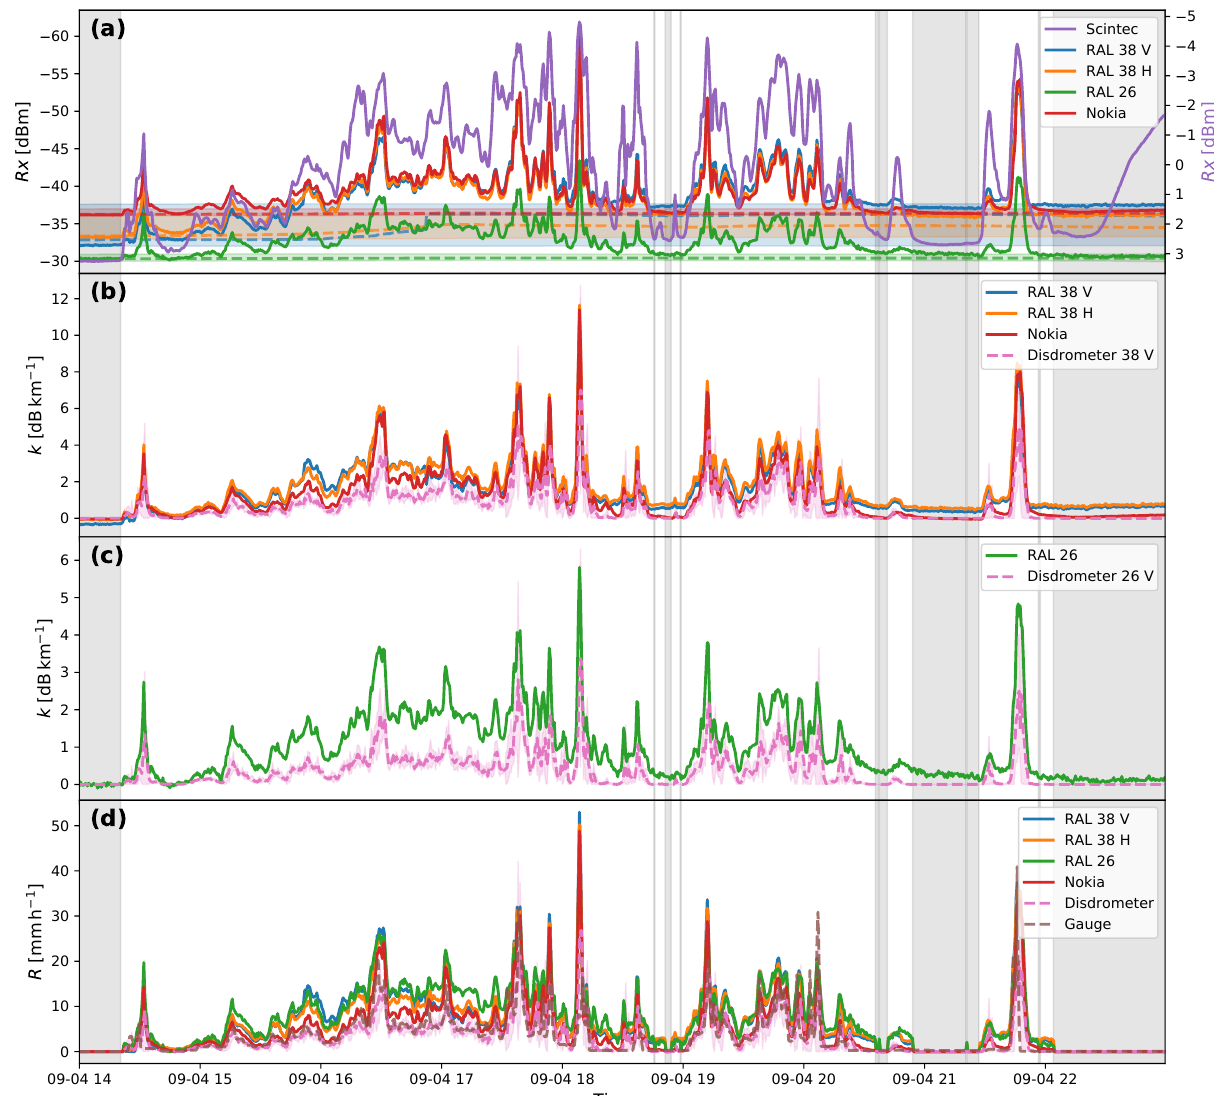
Figure 8. Time series of an event on 4 November 2015. (a) Received power levels (solid lines) and reference levels (median over dry periods in a 24h moving window: dashed lines). The 5th and 95th percentile power level over dry periods in a 24h moving window are indicated by the coloured shading. (b) Specific attenuation of the 38GHz links derived using the reference levels as well as the theoretical specific attenuation at 38GHz derived from the disdrometers. Both the weighted spatial average (dashed line) and weighted spatial standard deviation (shaded area) are shown. Panel (c) is the same as (b) , but for 26GHz. (d) Rainfall intensities derived from the link attenuations using the R – k power law and rainfall intensities derived from the disdrometers. Both the weighted spatial average (dashed line) and weighted spatial standard deviation (shaded area) are shown. The rainfall intensities derived from the tipping bucket gauge are indicated with the brown dashed line. Dry periods, as determined with the disdrometers, are represented by grey shaded